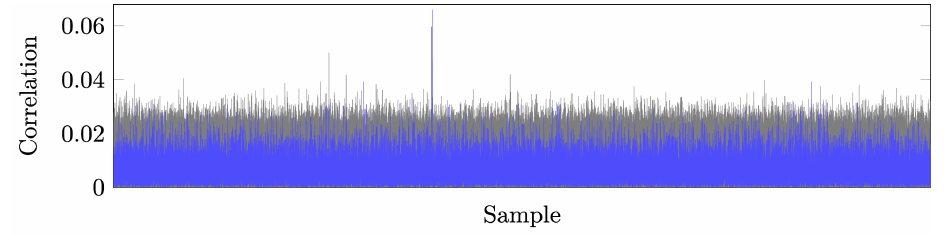
Figure 2: Correlation score when targeting the 1 st bit in the 3 rd s-box when fixing attacking correct